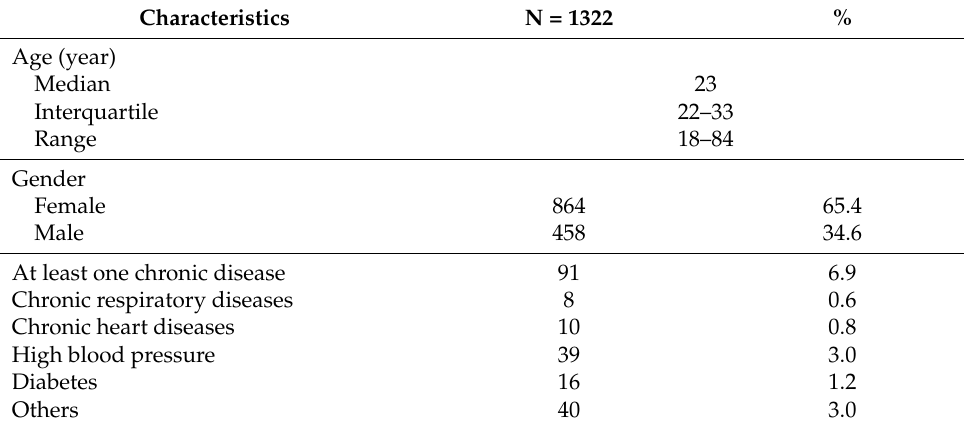
Table 1. Characteristics of the included